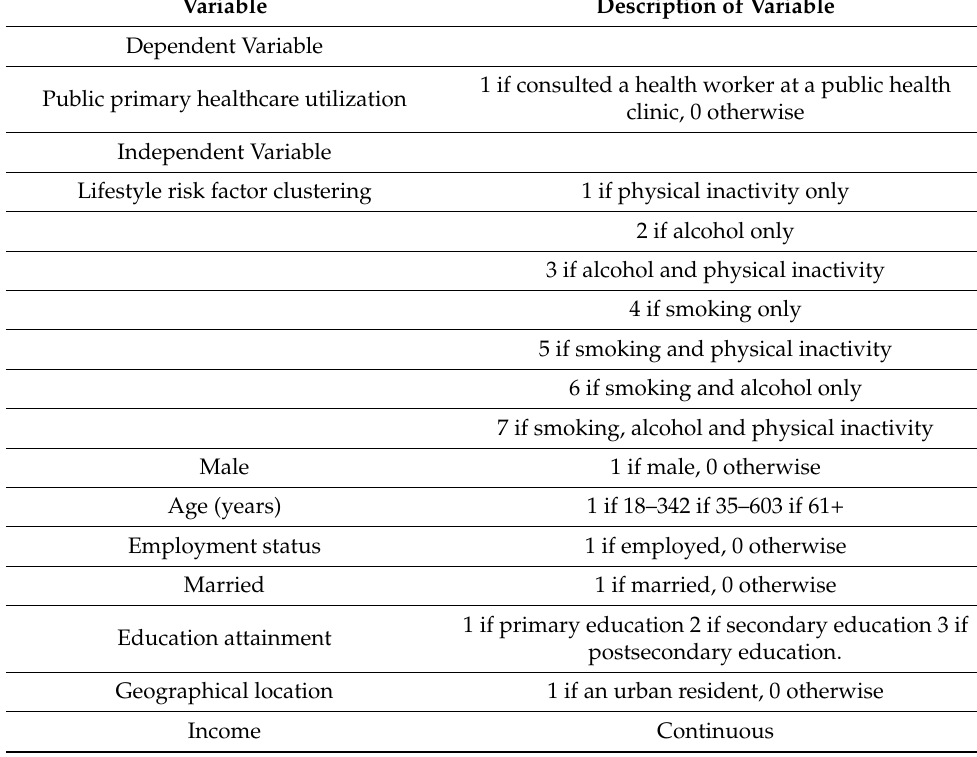
Table 1. Summary description of